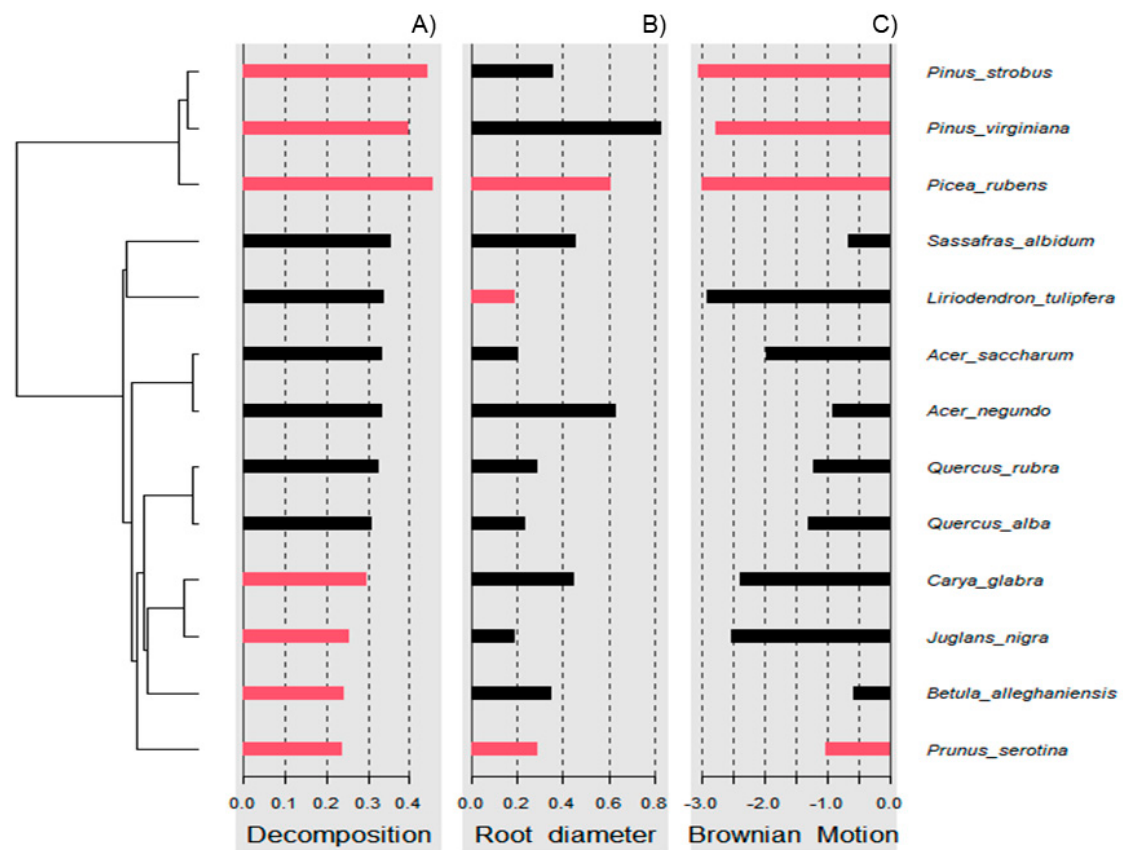
Figure 4. Local indices of phylogenetic association (LIPA) for ( A ) decomposition, ( B ) root diameter, and ( C ) Brownian motion. Red bars indicate significance with respect to Local Moran’s index. As it relates to decomposition, bimodal clustering was observed. Particularly, high sensitivity values were observed for pine species. Meanwhile, low sensitivity values were observed for species distant to pines (i.e., black cherry). With respect to root diameter, sensitivity values were sparse.